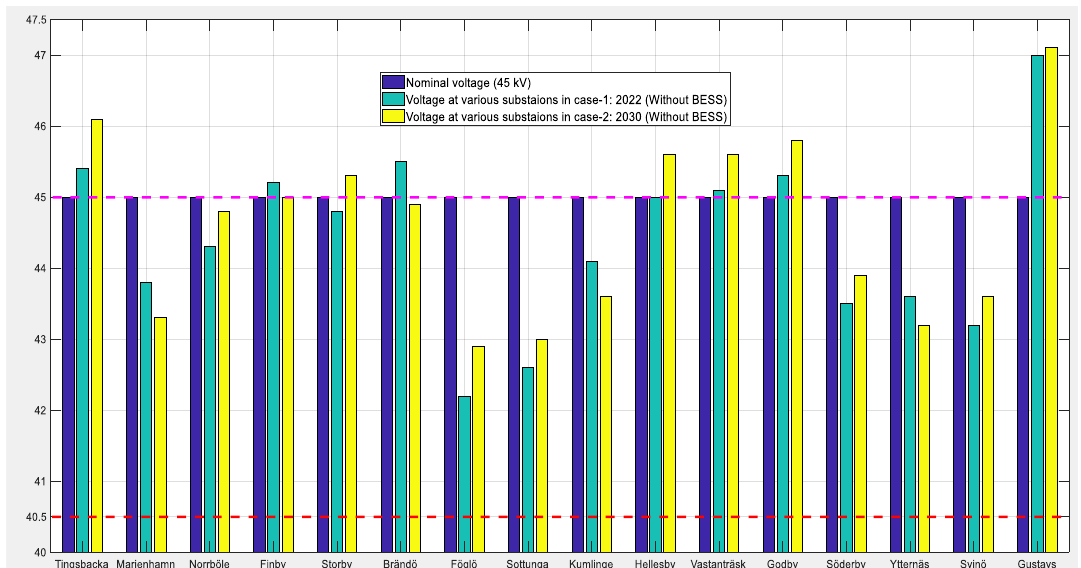
Figure 9. Nominal and operating voltages at the substations in the base case.